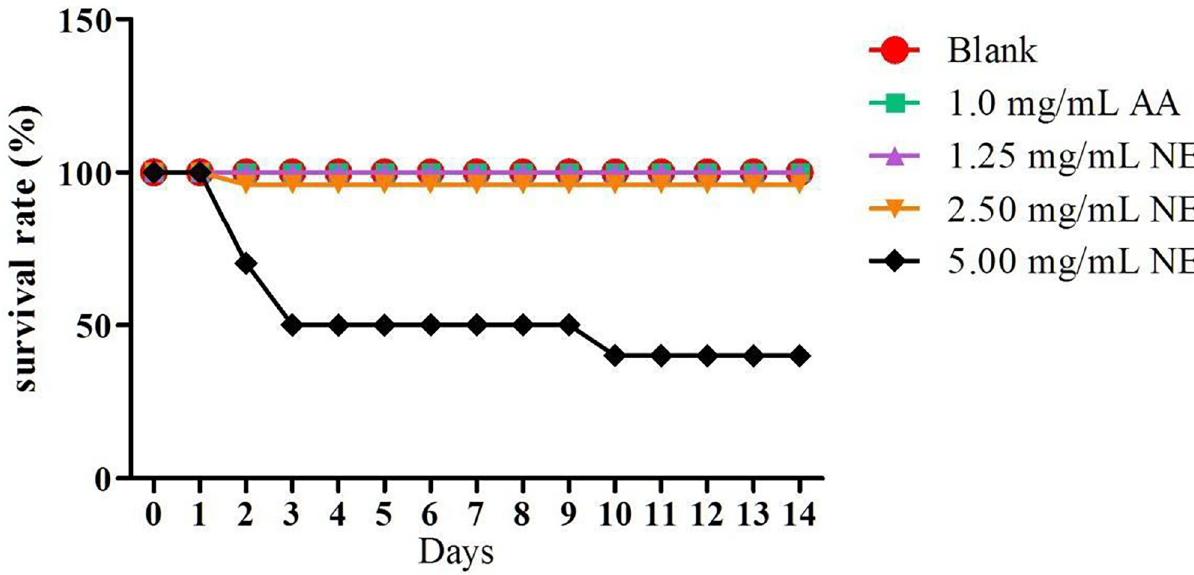
Fig 6. The effect of treatments on survival rate of zebrafish (prolonged toxicity;n = 10). Notes: Blank = untreated samples; AA = Ascorbic acid; NE = Nanoemulsions.